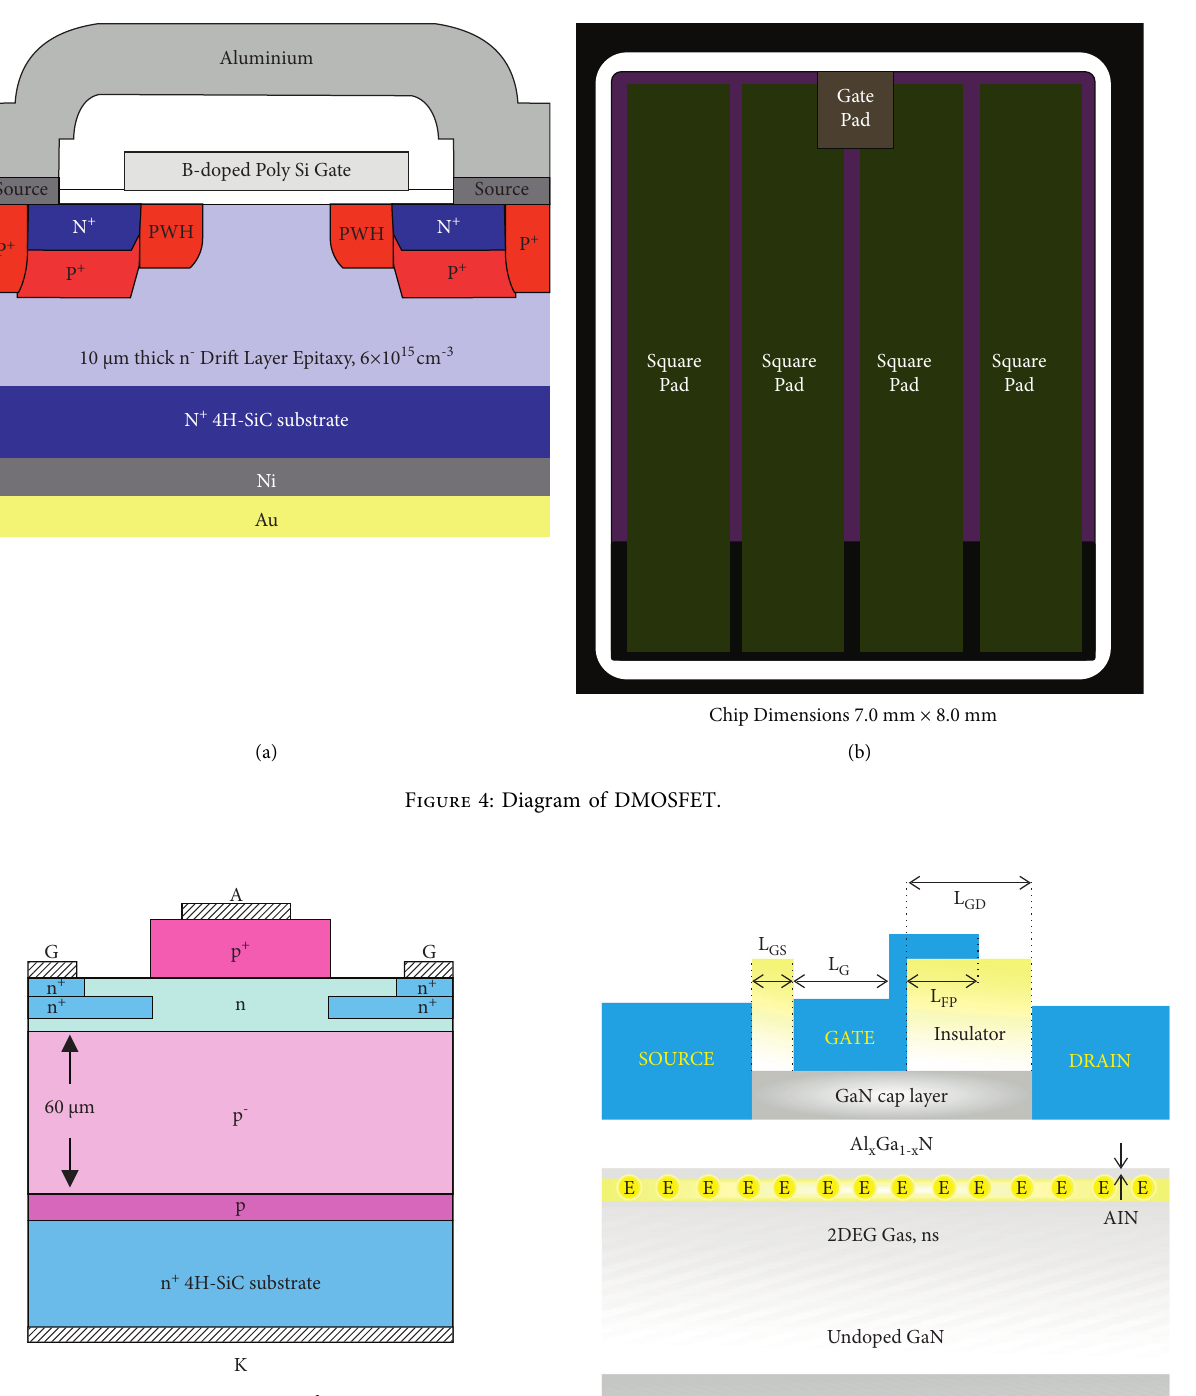
Figure 5: Structure of Si-C.